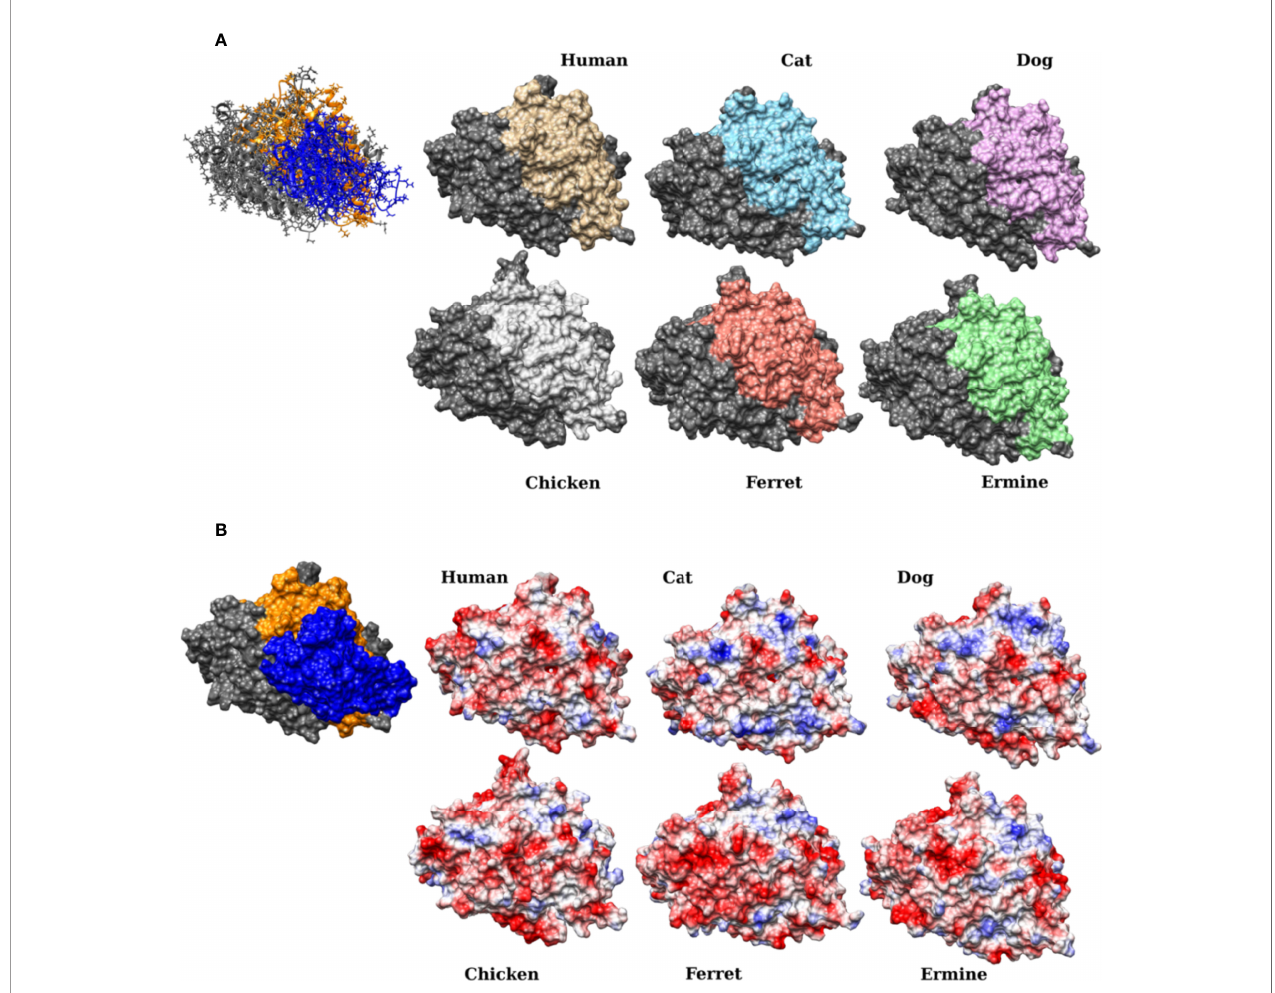
FIGURE 7 | Isosurface representations and electrostatic (Coulombic) maps of the predicted ACE2 receptor structures for various animal hosts. The fi gure shows the isosurface representations of the predicted structures of the ACE2 (A) and the corresponding Coulombic coloring of the surface representations (B) . The region that is likely to affect the binding (residues 19-90 and 324-393) is depicted in distinct colors whereas the rest of the PD domain is depicted in dim grey. The viral receptor is hidden to show the overall shape and surface charge of the binding surface on the ACE2 receptor. For clarity, the human receptor-RBD complex is shown on the left of both atomic and its isosurface representations (panels A and B , respectively), in the same orientation as of the other models. In the latter, the RBD is in blue, the region having residues 19-90 and 324-393 is depicted in orange and the remainder of the PD domain is in dim grey. In panel B, the positively charged, negatively charged, and hydrophobic (neutral) regions are depicted in blue, red and white,